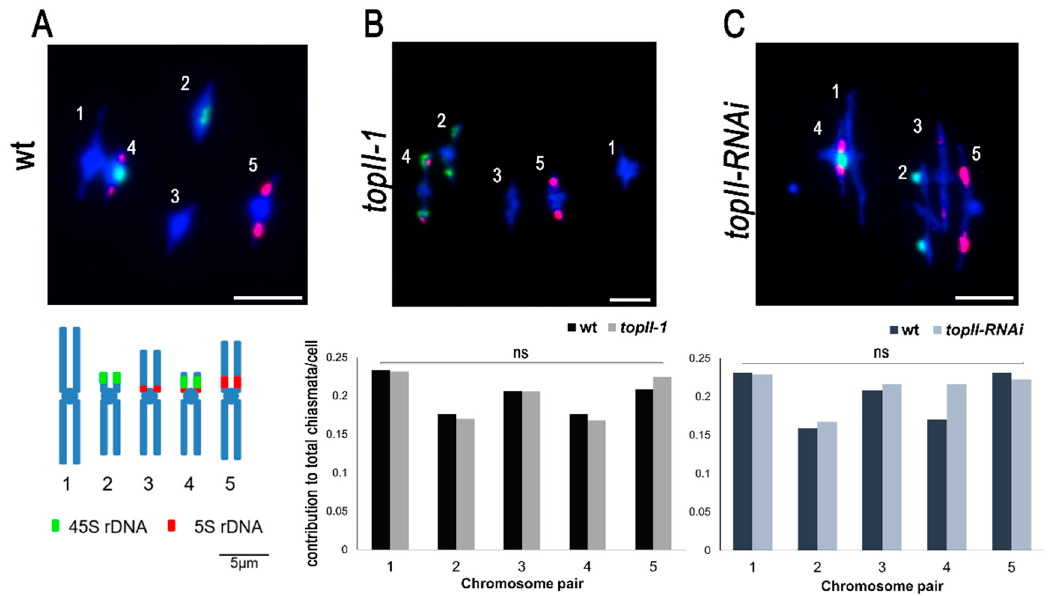
Figure 5. Chiasma frequency and distribution are not modified in topII plants. ( A ) Wild-type metaphase I nucleus and mitotic ideogram with the localisation of rDNA FISH probes (45S in green and 5S in red). Scale bars: 5 µm. ( B ) topII-1 representative metaphase I nucleus and graph showing chiasma distributions per chromosome in wt (Ws) and topII-1 . ( C ) topII-RNAi representative metaphase I meioses and graph showing chiasma distribution per chromosome in wt (Col) and topII-RNAi . Mann–Whitney U-test, ns: not significant.